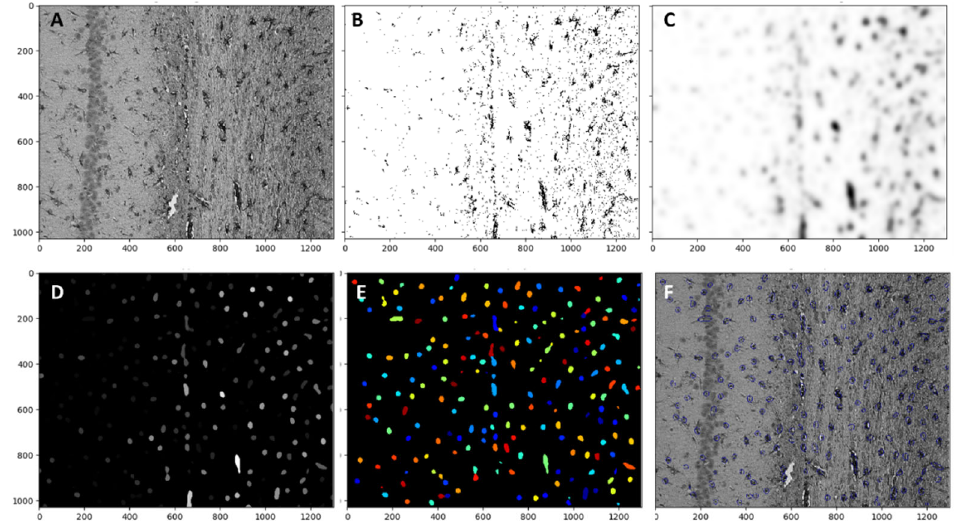
Figure 9. ( A ) Pipeline for the astrocyte quantification. Raw image from the microscope. ( B ) Threshold with lower and upper bounds 0.006 and 0.8 respectively with a method of minimum cross-entropy. With a threshold smoothing scale of 0. ( C ) the threshold image was smoothed with a Gaussian filter. ( D ) “Enhanceorsupress” feature was used, and the smoothed image was enhanced with dark holes ranging from 1 to 20 pixels in size. ( E ) Cells are identified by the “identify primary object” function with a size range from 8 to 80 pixels. New threshold bounds from 0.000001 to 0.004 were used. ( F ) The overlay of identified objects with the initial image.